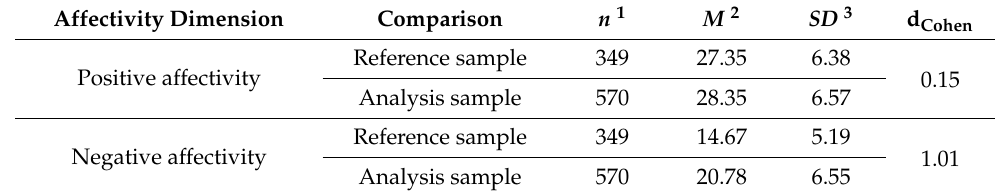
Table 4. Differences in the participants’ positive and negative affectivity compared to a representative reference